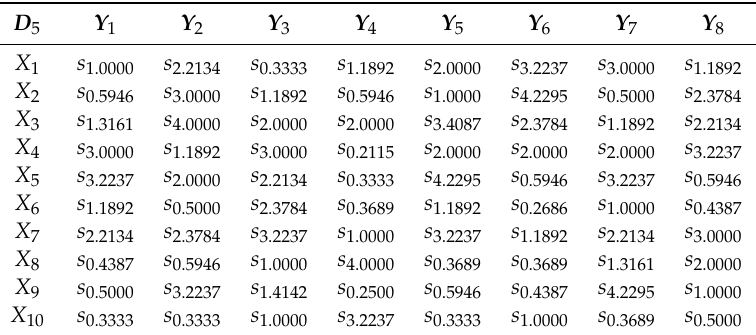
Table A10. Deterministic linguistic evaluation information matrix of D 5